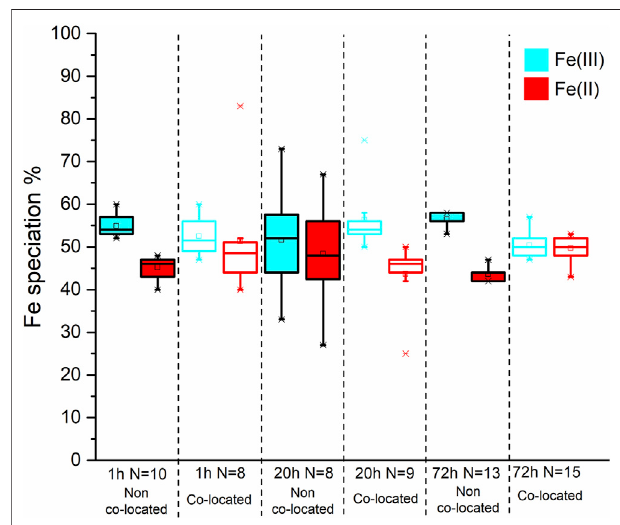
FIGURE 10 | Box and whisker plot diagrams showing the changes in Fe speciation over the course of the experiment. The box and whisker plots for the starting material have adotted outline.The box and whisker plots from the non co-located regions have a solid black outline while those from the co-locatedregionshavecolouredoutline.InbothspatialregionstheFe(III)and Fe(II) data is represented with blue and red, respectively.